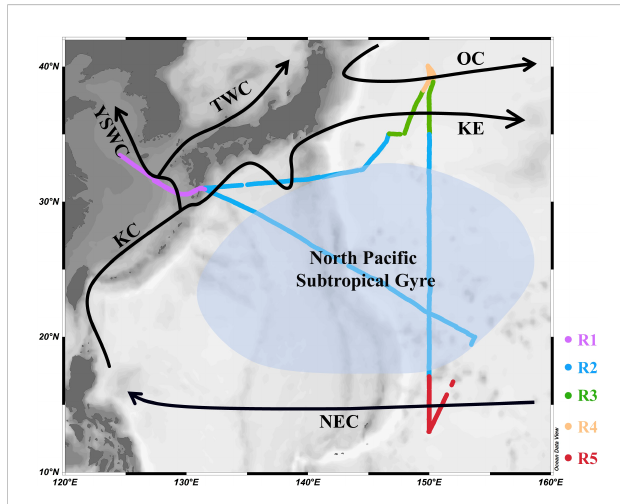
FIGURE 1 Track of the sampling cruise (R1 to R5) and the major surface currents (solid black arrows) in the Northwest Paci fi c Ocean (OC: Oyashio Current; KE: Kuroshio Extension; KC: Kuroshio Current; TWC: Tsushima Warm Current; YSWC: Yellow Sea Warm Current; NEC: North Equatorial Current; R1: shallow marginal sea region (SMSR); R2: North Paci fi c Subtropical Gyre (NPSG); R3: Kuroshio-Oyashio Con fl uence Region (KOCR); R4: OC region (OCR); R5: NEC region